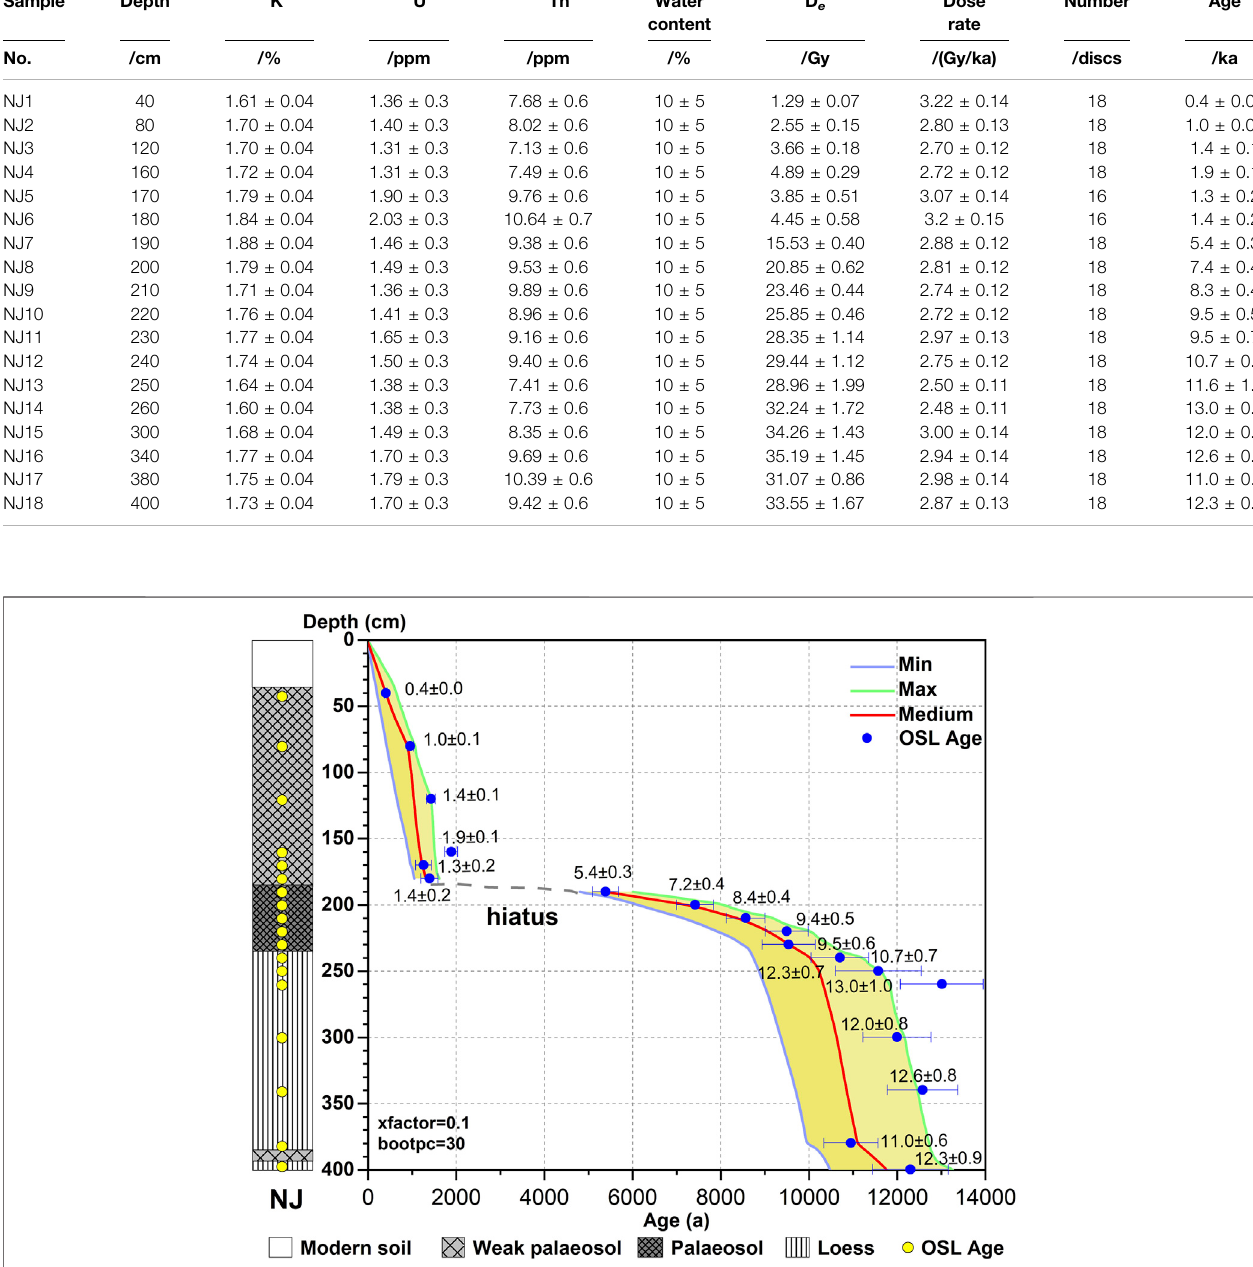
The quartz fraction of 63 – 90 μ m was extracted for equivalent dose (D e ) determination. Extracted quartz was checked for purity using infrared stimulated luminescence (IRSL) measurements